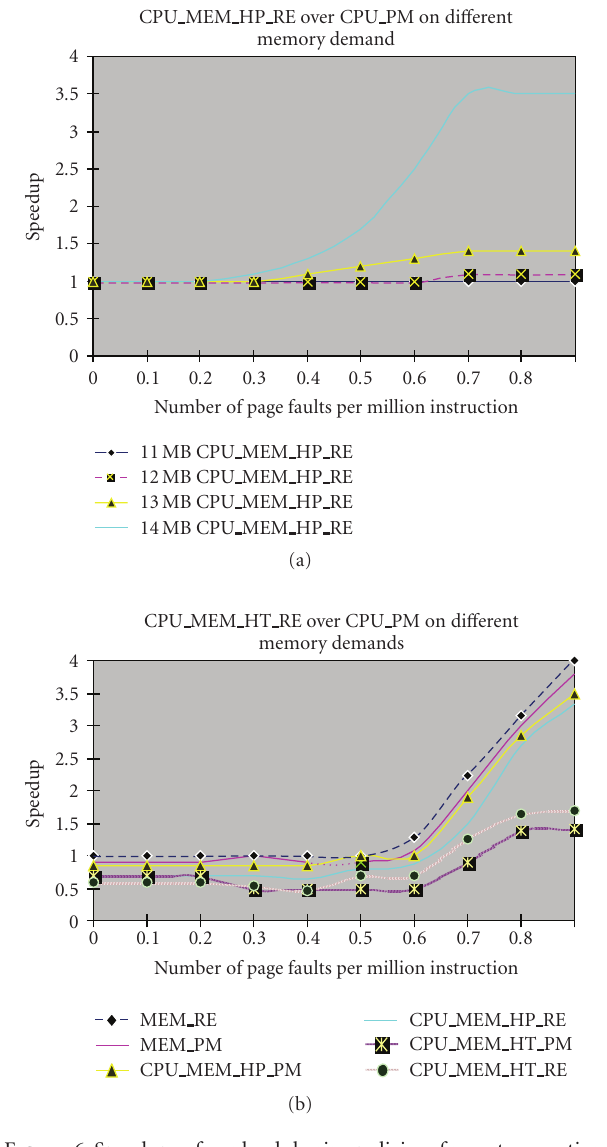
Figure 6: Speedups of our load sharing policies of remote execution over CPU PM as both the page fault rate and mean memory demand increase on “trace 0” for the high performance approach (CPU MEM HP RE, (a)) and for the high-throughput approach (CPU MEM HT RE, (b)).